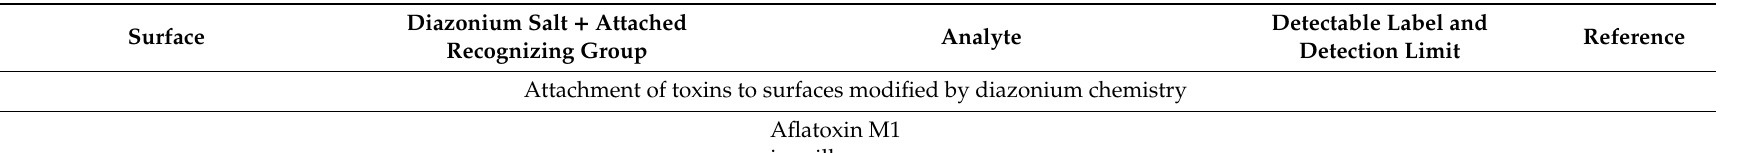
Table 3. Detection of toxins. SWCNT—single-walled carbon